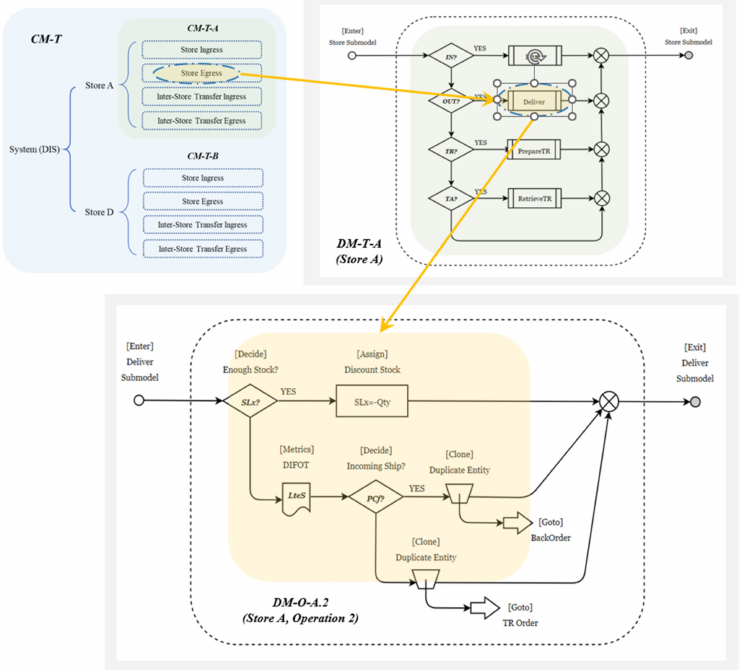
Figure 22. Conversion of CM-T-A to DM-T-A (detailed in Figures 18 and 21) and finally into one of the Design Model—Operations sub-planes (DM-O-A.2) highlighted in